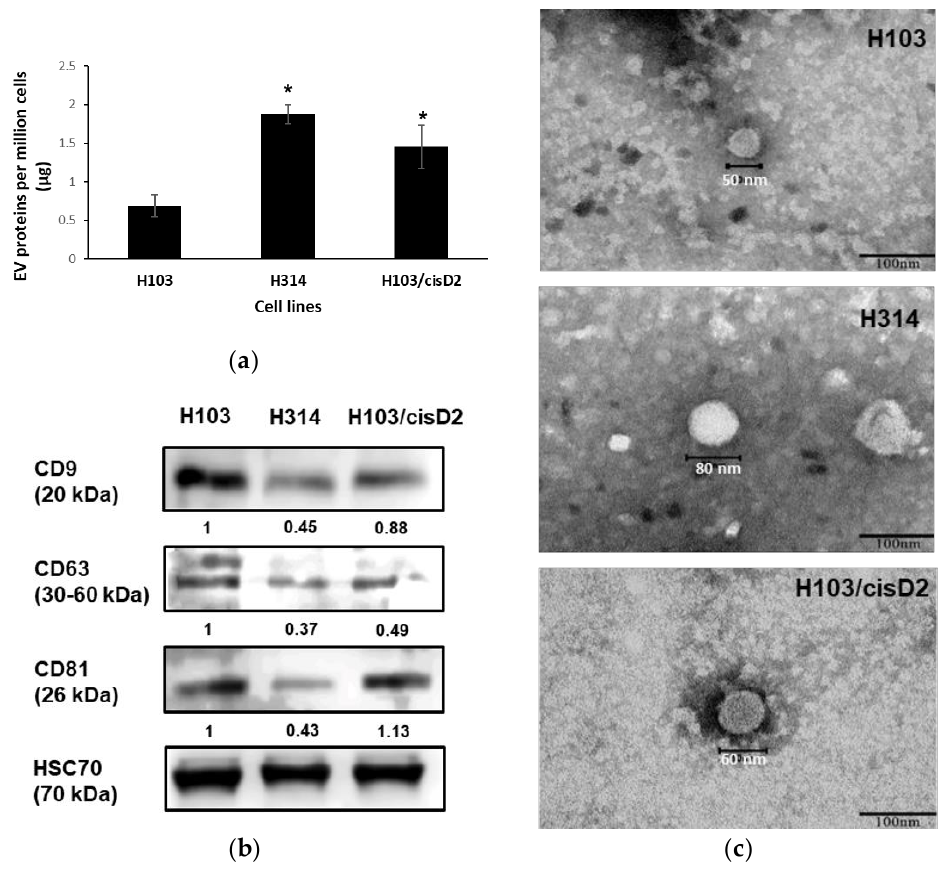
Figure 2. Characterization of oral squamous cell carcinoma (OSCC)-cells derive extracellular vesicles (EVs). ( a ) EVs production of OSCC cells. * indicate significant differences, n = 3, p < 0.05 (One-way Annova, Tukey’s post-hoc). ( b ) Western blot of EV marker protein expression identified in OSCC cells-derived EVs. The images are representative of three independent experiments (Figure S4). All the signals were normalized against intensity of HSC70. ( c ) TEM images of single EV derived from OSCC cell lines (scale bar: 100 nm). Table 1. Size distribution of oral squamous cell carcinoma (OSCC) extracellular vesicles (EVs) analyzed with Nanosight